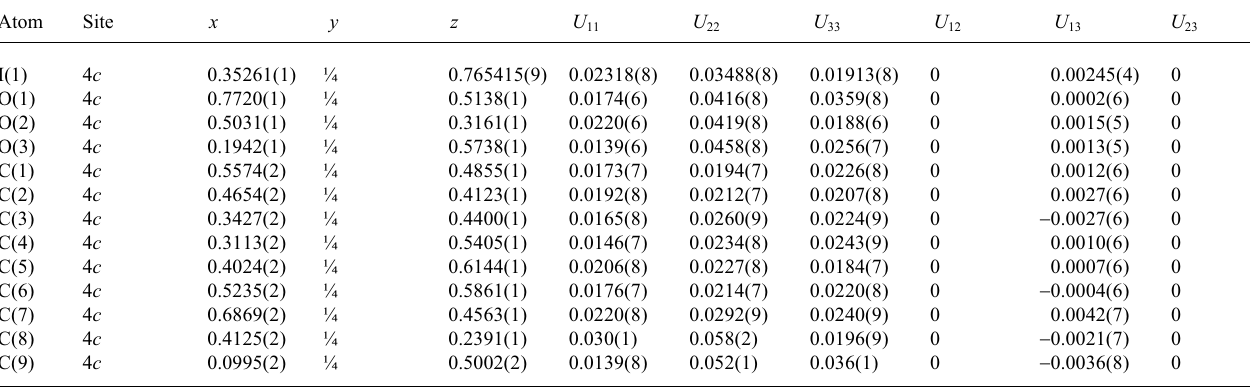
Table 3. Atomic coordinates and displacement parameters (in Å 2 )